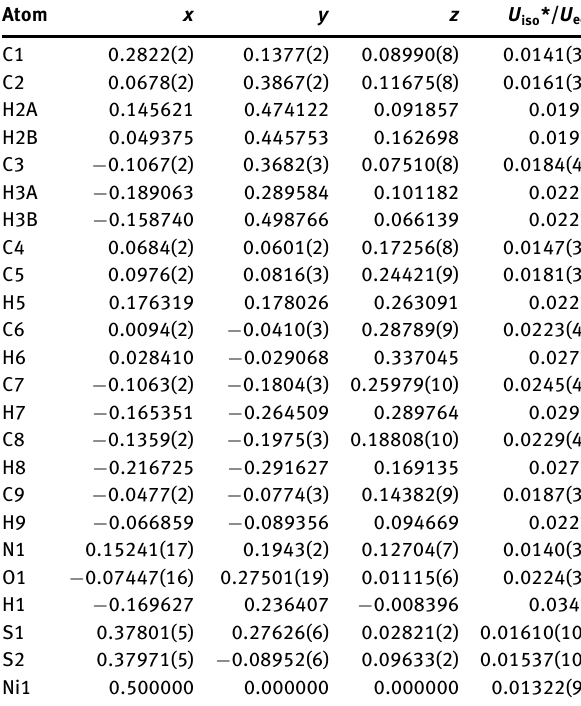
Table 2: Fractional atomic coordinates and isotropic or equivalent isotropic displacement parameters (Å 2